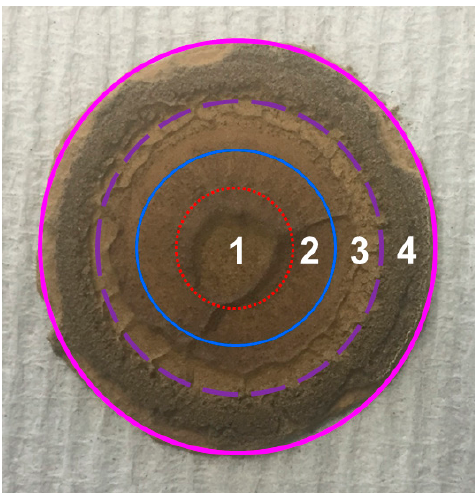
Figure 13. Sample preparation of paste powder by horizontally dividing four sections.